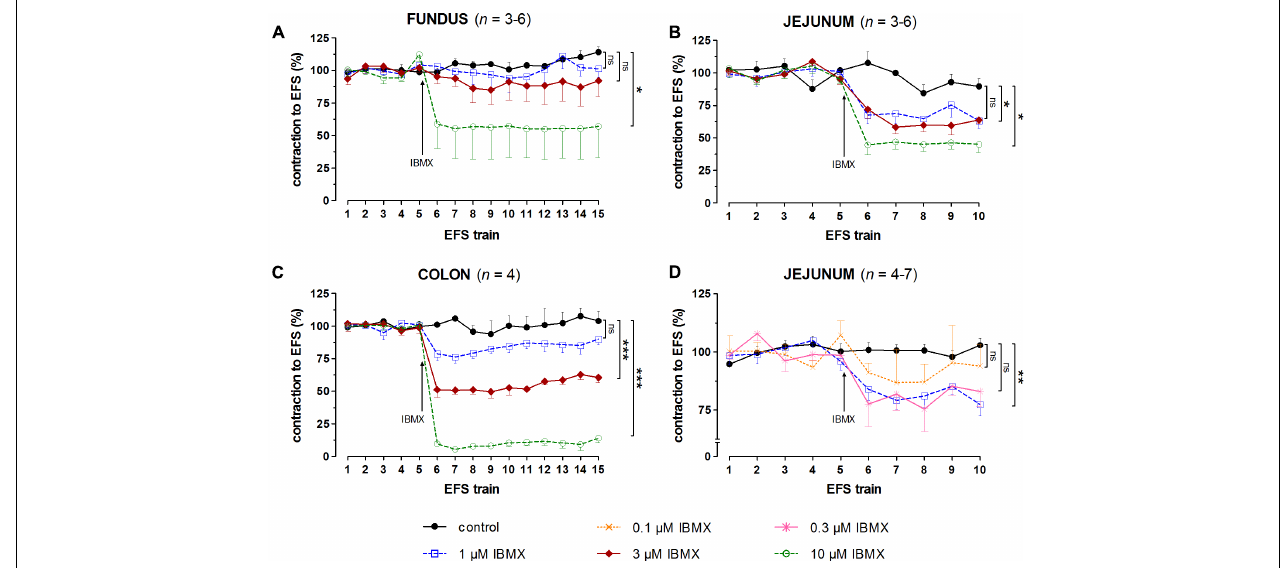
FIGURE 4 | Influence of 1, 3, and 10 µ M (A–C) and 0.1, 0.3, and 1 µ M (D) IBMX on submaximal electrically induced cholinergic contractions at V 50% (10 s trains at 4 [fundus] or 8 [jejunum and colon] Hz, 0.5 ms, interval of 5 [fundus and colon] or 10 [jejunum] min) in murine fundus (A) , jejunum (B,D) , and colon (C) circular smooth muscle strips. The number of the consecutive stimulation trains before and after adding IBMX is given on the y-axis. Contractions are expressed as percentage of the mean of the five contractions before adding IBMX (trains 1–5). Experiments were performed in the continuous presence of 4 µ M guanethidine,